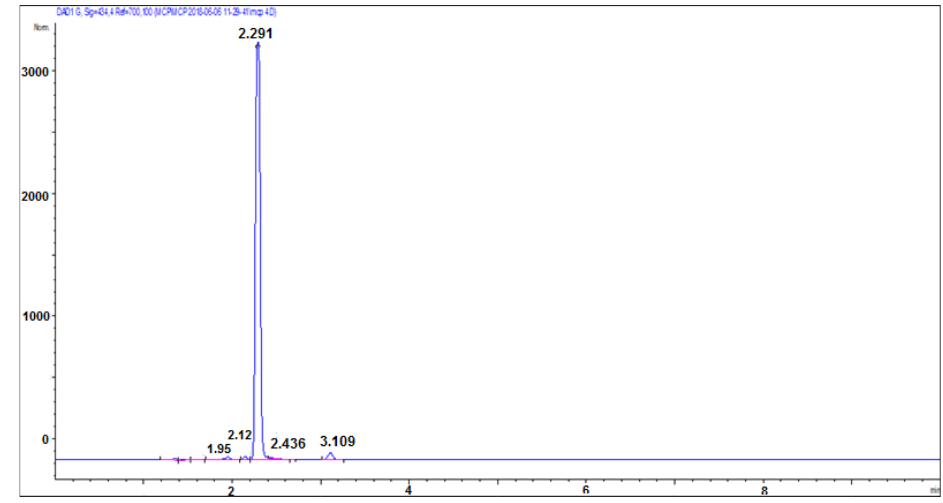
Figure 4. HPLC-DAD chromatogram of 2.5 mM mCP standard solution detected at 434 nm wave- length. Eluent composition: 70% CH 3 COONH 4 pH 8.0 and 30% CH 3 CN.